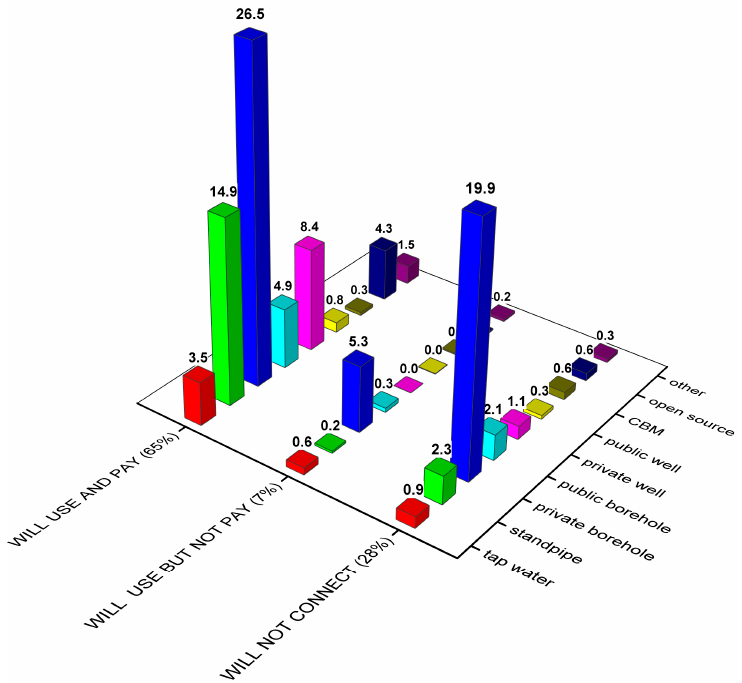
Figure 4. Willingness to connect to the piped water supply system depending on water user type.